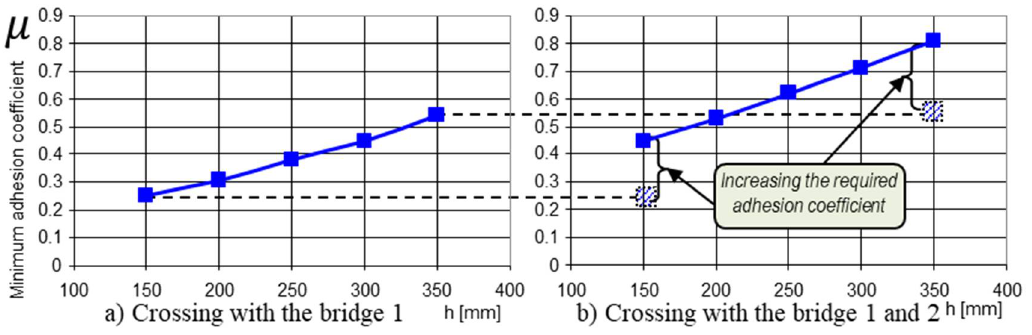
Figure 12. The variation in the µ [ − ] necessary to cross an obstacle as a function of its height. The data used for the calculations are found in Appendix A and Table A1. Given the geometric characteristics of the towing robot and the mobile platform, and that changes are possible depending on the dimensions of the operational platforms, the robot can be used for different missions; we consider the data used to be sufficient: ( a ) crossing with bridge 1; ( b ) crossing with bridges 1 and 2.